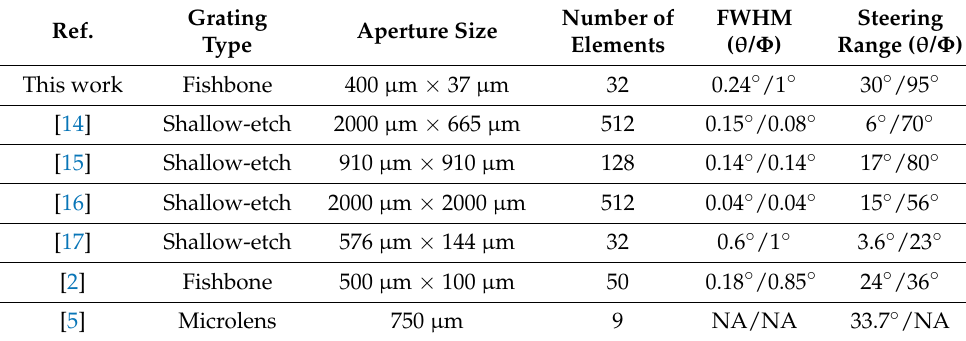
Table 2. OPA grating emitter summary and